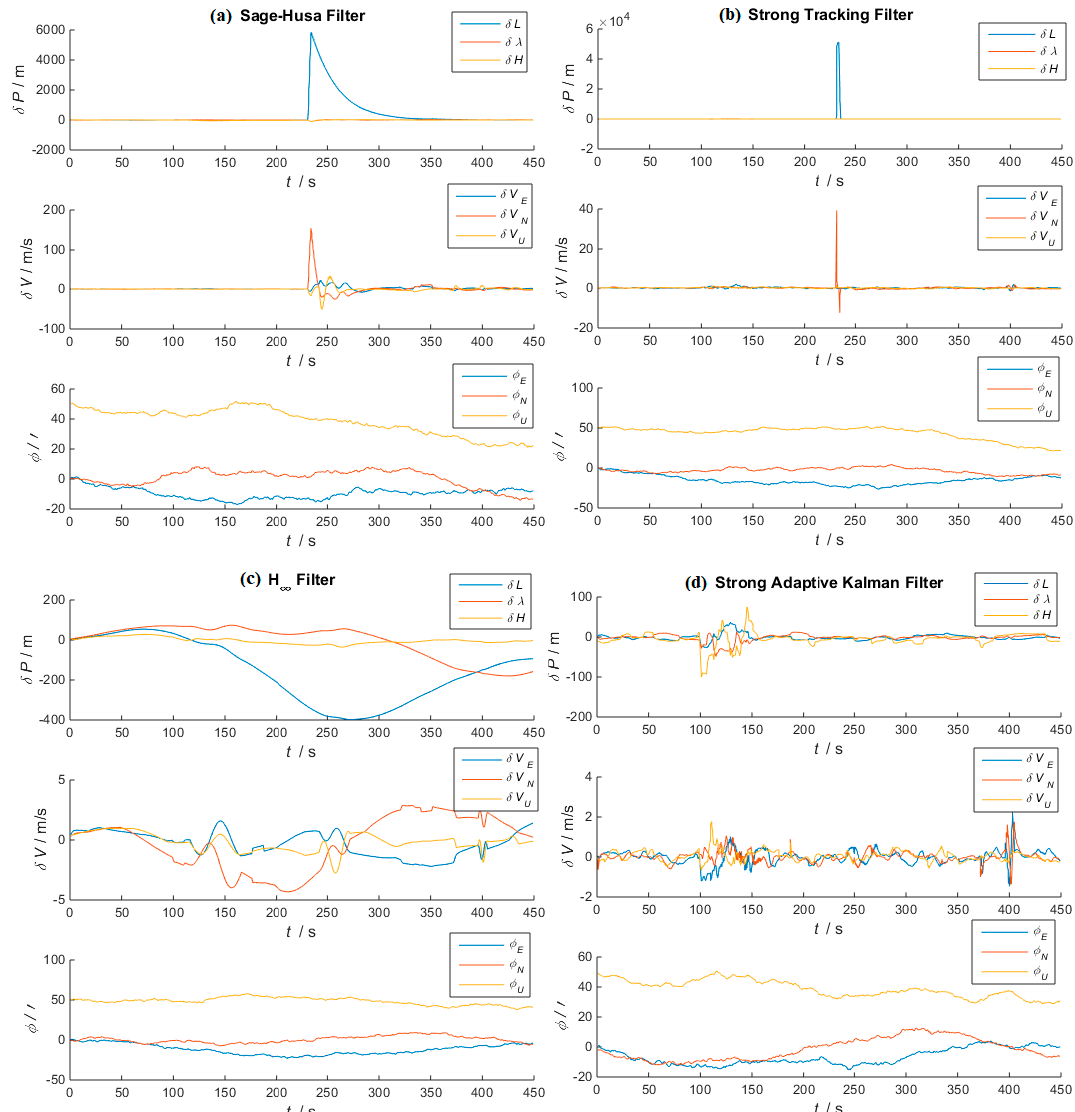
Figure 4. The diagrams of errors obtained by four types of filtering algorithms in the scene 2 designed in 3.1.2. ( a ) SHAKF; ( b ) STF; ( c ) H ∞ filter; ( d ) SAKF